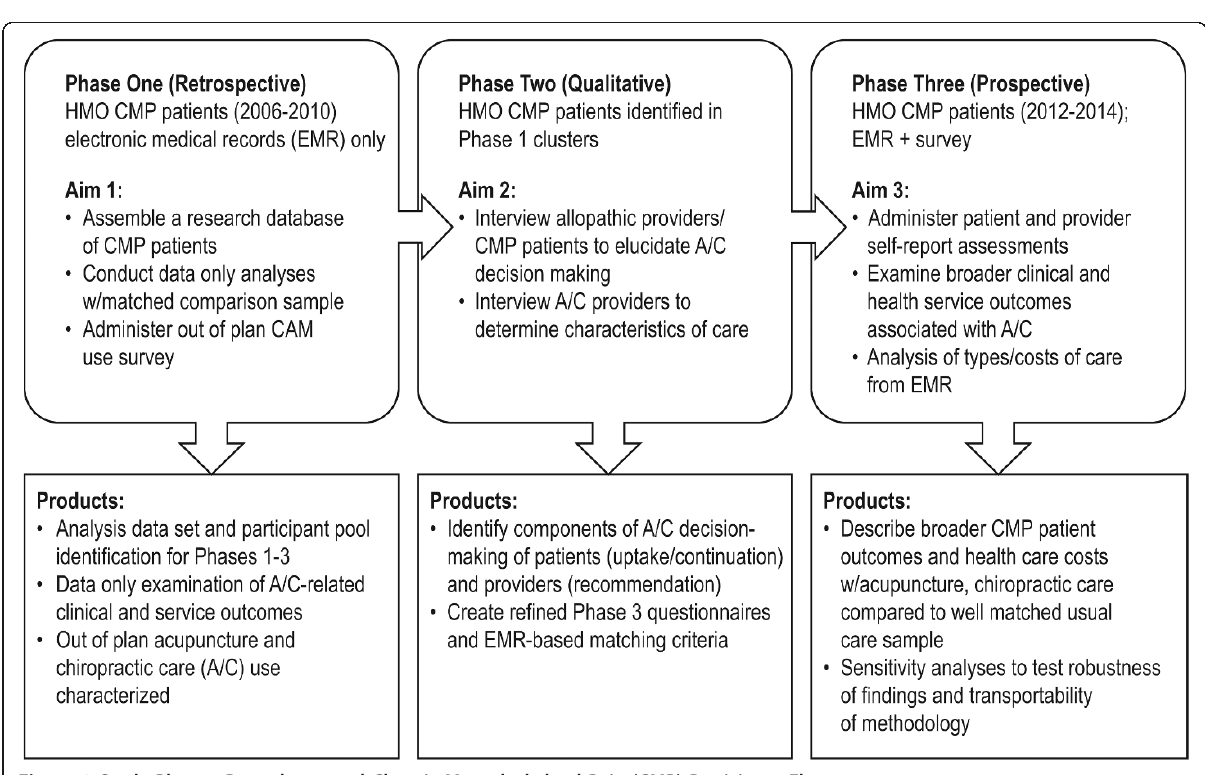
Figure 2 Study Phases, Procedures, and Chronic Musculoskeletal Pain (CMP) Participant Flow